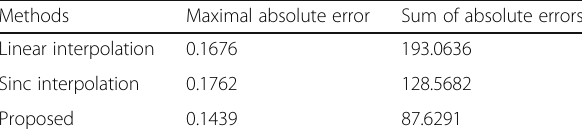
Table 1 Computer simulation set #1 sinogram estimation errors